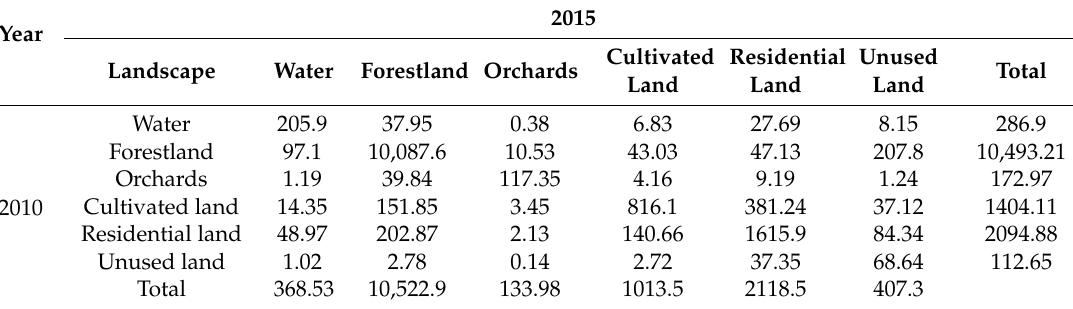
Table 22. The landscape transition matrix from 2010 to 2015 (km 2